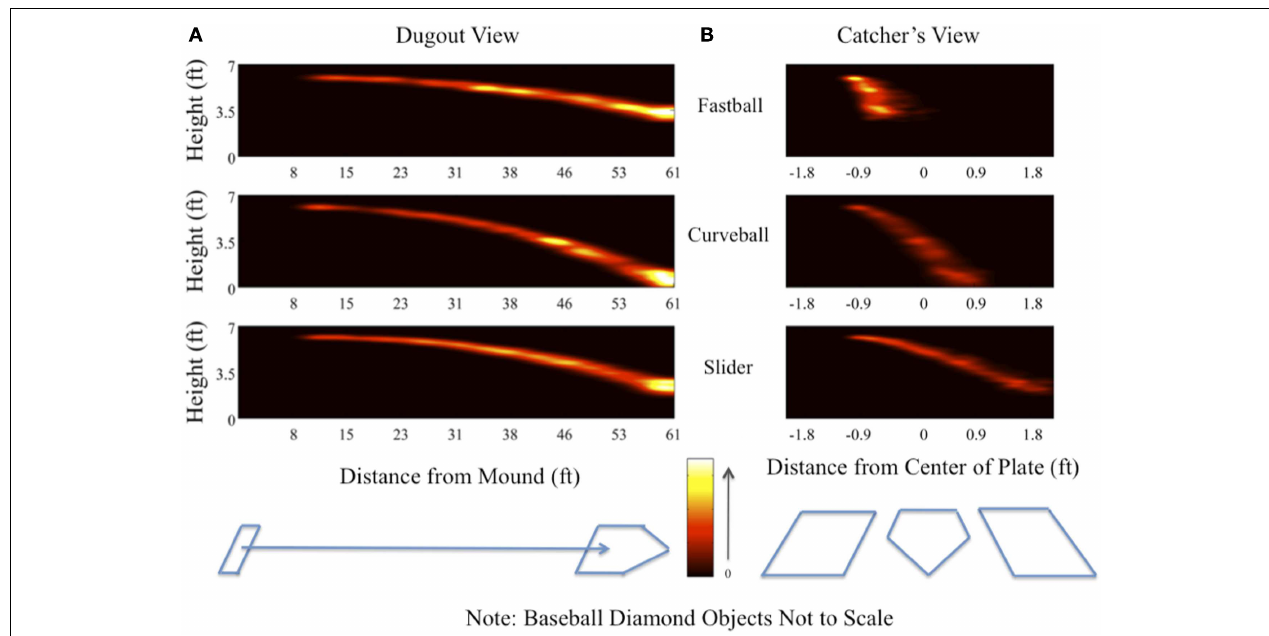
in space. Repeating this process for all subjects and all trials results in a distribution of points in space for each pitch at which peak discrimination occurred in a given trial and for a given pitch.The “dugout” view (A) shows a two-dimensional projection along the initial trajectory of the pitch, while the “catcher’s” view (B) shows the two-dimensional projection in the plane perpendicular to the pitch’s initial trajectory. Color heat maps indicate the height of the